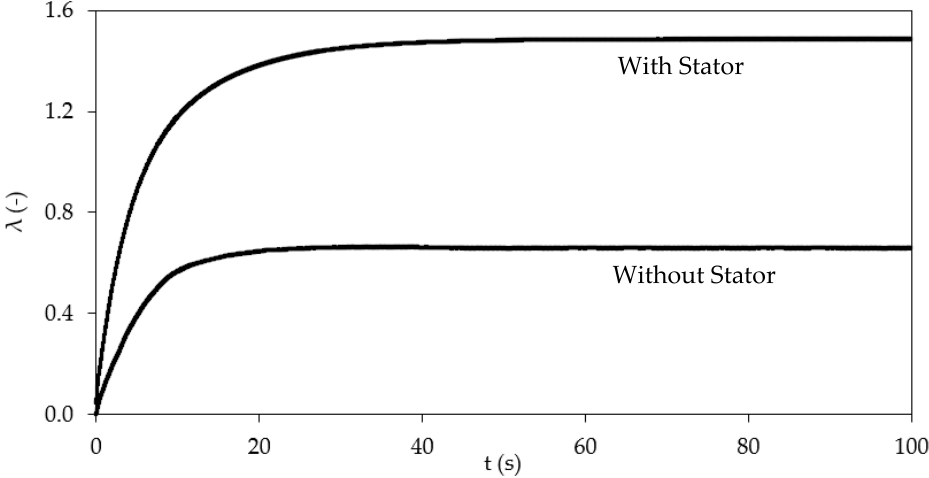
Figure 10. Variations in the Tip Speed Ratio of the VAWTs with and without stator.